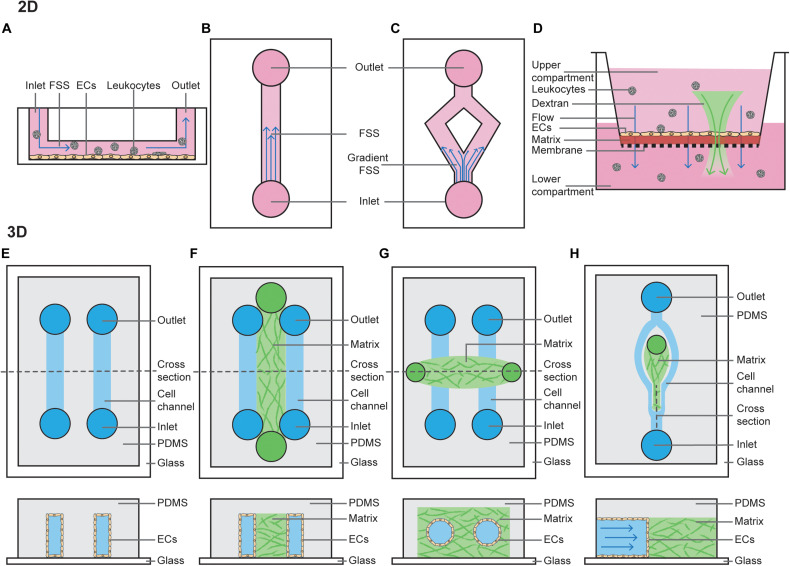
2D and 3D techniques to model FSS. (A) Cross section of a parallel plate flow chamber in which a monolayer of ECs is cultured on the bottom of the channel. Perfusion of media, containing growth factors and/or leukocytes, is added through the inlet and outlets. (B) Top view of a parallel plate flow chamber device to mimic steady laminar FSS or oscillatory laminar FSS, when fluid is pumped in a bidirectional manner. (C) Top view of a bifurcated channel to model gradient shear stress regions. (D) Cross section of a transwell filter system, where ECs are cultured on a thin ECM matrix on top of a porous membrane. The hydrostatic pressure difference between the upper and lower compartment models interstitial flow through the monolayer of ECs. Addition of fluorescent dextran or leukocytes to the upper compartment can be used to study permeability or leukocyte TEM. (E) Top view and horizontal cross section of a PDMS-only 3D microchannel in which ECs are grown inside the channels. (F) Top view and horizontal cross section of a PDMS-hydrogel hybrid 3D microchannel in which ECs are grown in the outer channels, and then allowed to migrate into the central hydrogel. (G) Top view and horizontal cross section of a hydrogel-only 3D microchannel in which ECs are grown fully surrounded by hydrogel. (H) Top view and vertical cross section of a PDMS-hydrogel hybrid 3D microchannel incorporating bifurcation.